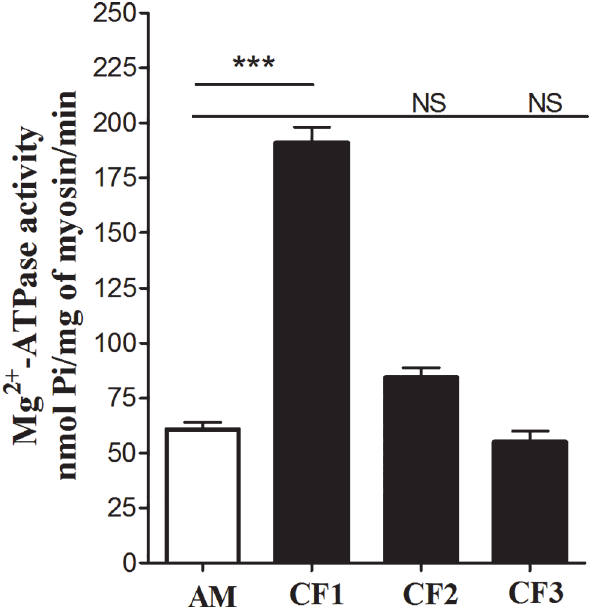
Fig 2. Effect of the combined fractions (CF1, CF2 and CF3) collected from the Sepharose CL 6B gel- filtration chromatography on the actin-activated Mg 2+ -ATPase activity of myosin. Note, that the CF3 fraction containing pure unphosphorylated myorod did not affect Mg 2+ -ATPase activity of myosin. Concentration used: mussel myosin, 0.1 mg/ml; rabbit F-actin, 0.2 mg/ml; CF1, CF2, CF3, 0.1 mg/ml. Each column represents the mean of results from three experiments ± SEM, one-way ANOVA, * :p <